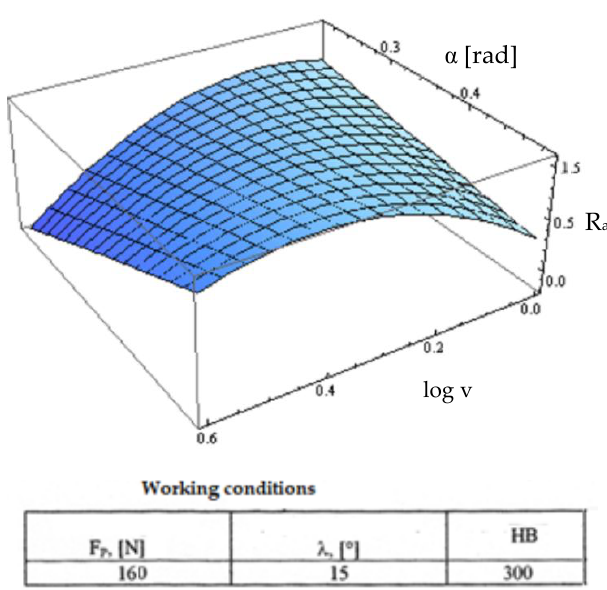
Figure 15. Influence of the cutting speed v and radial force F p on roughness R a.